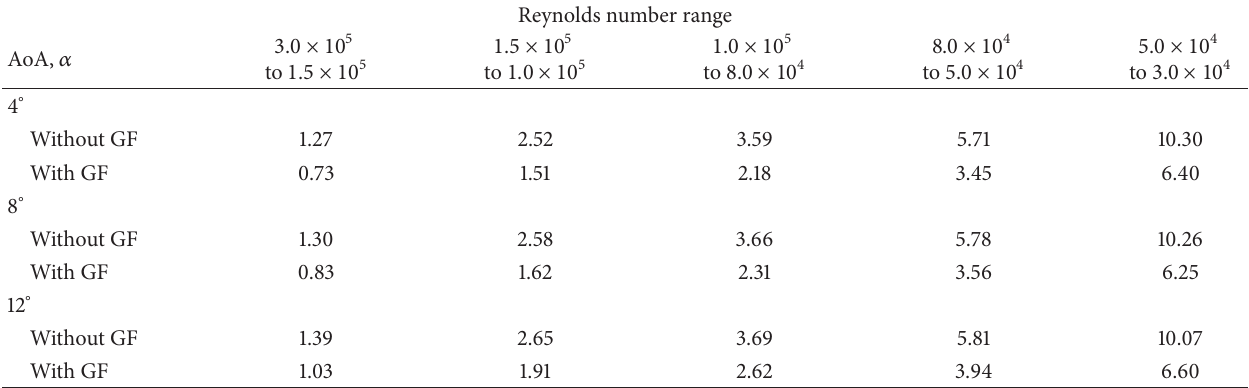
Table 4: Percentage Increment in 𝐶 𝐷 per every 10,000 decrease in Reynolds number for different ranges of Reynolds number. Reynolds number range